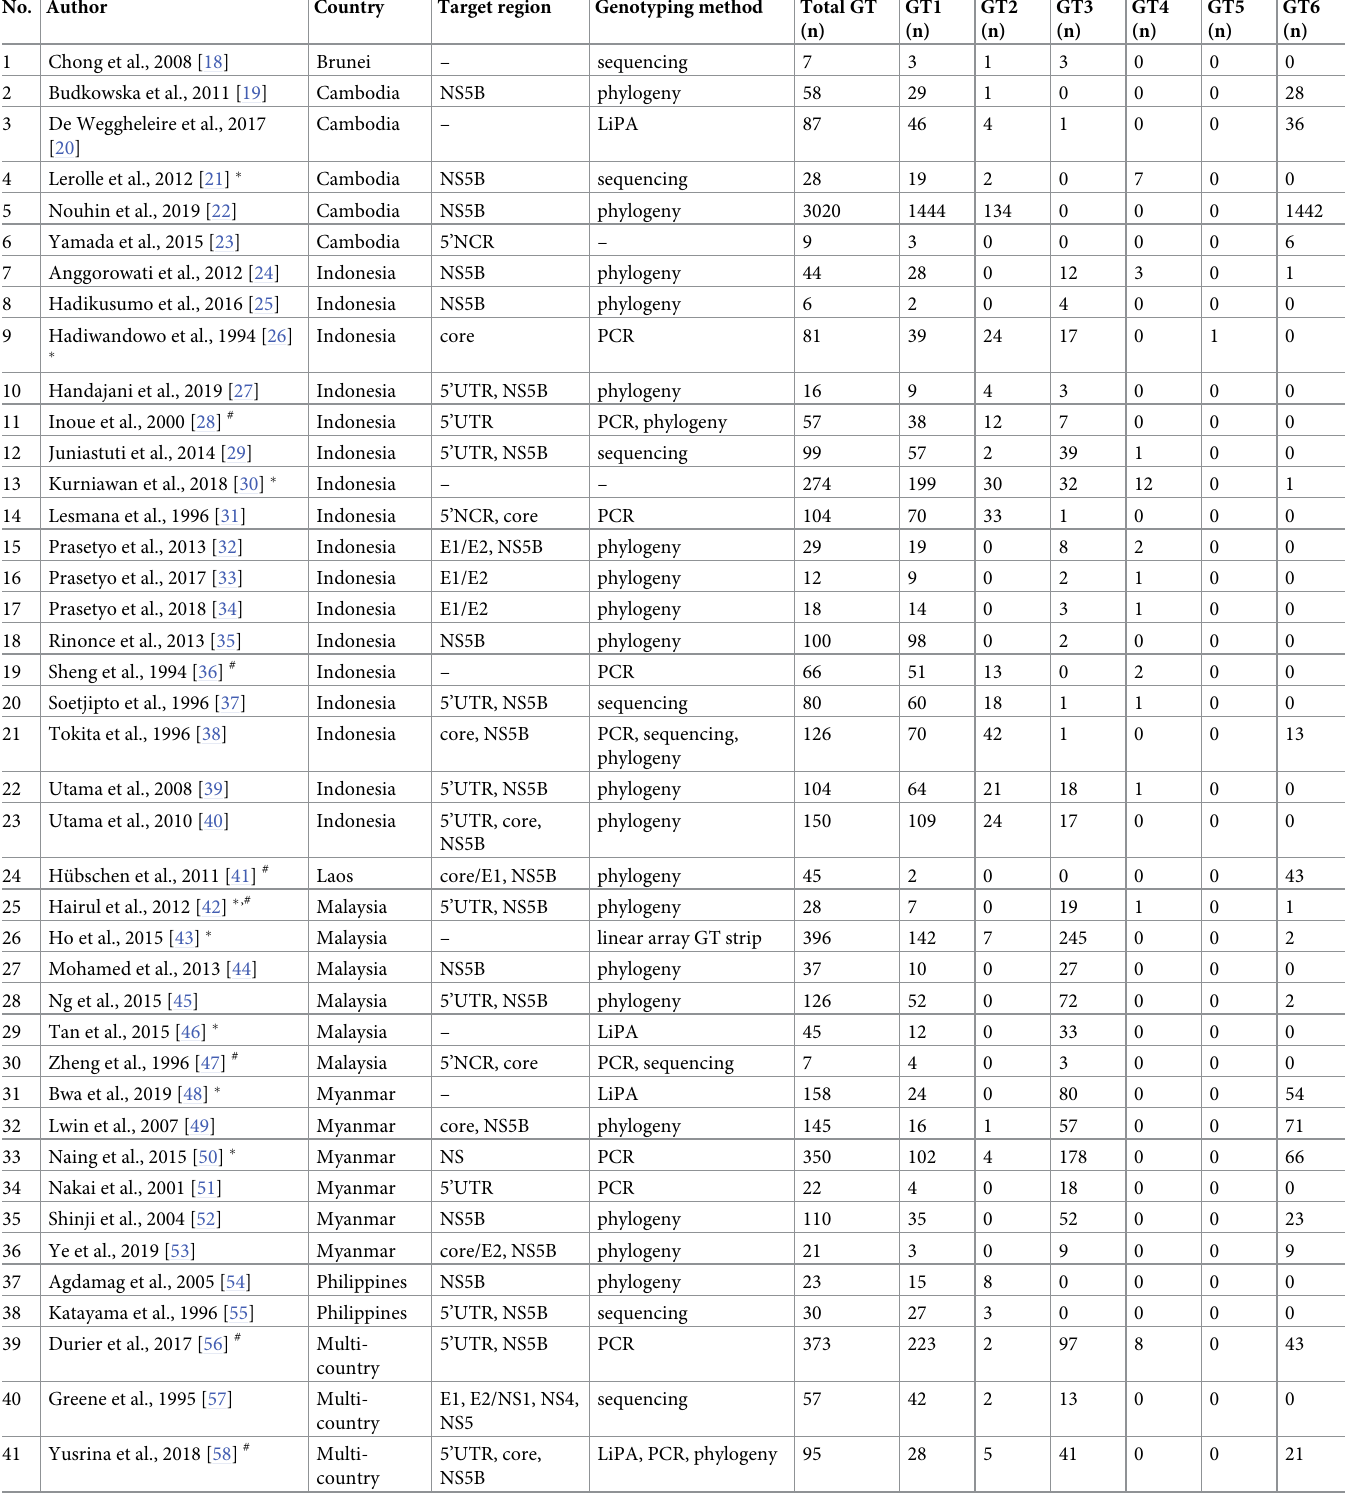
Table 1. Characteristics of the selected studies reporting HCV genotypes in Southeast